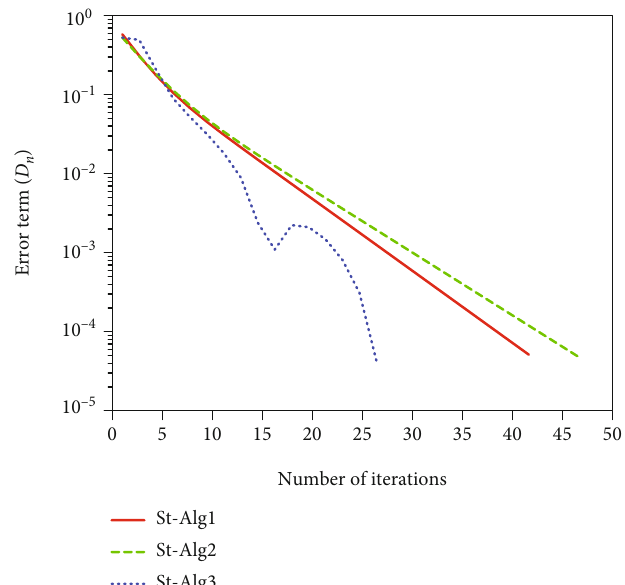
Figure 2: Numerical computational behavior of Algorithm 1:, Algorithm 2:, and Algorithm (4.2) while κ